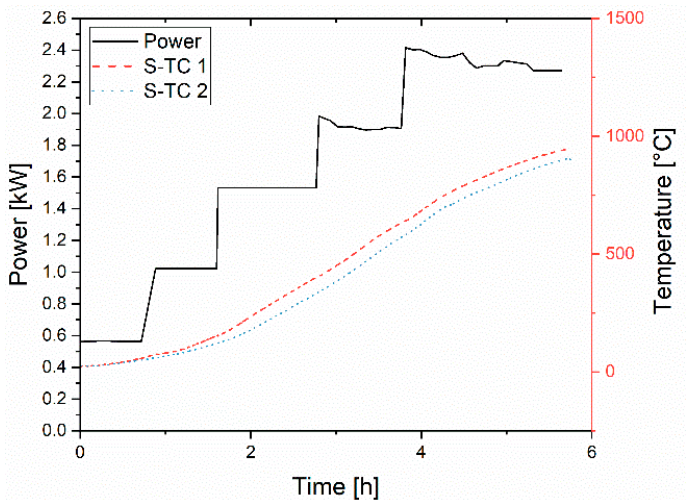
Figure 15. Experimental performance of LFP-C in Design 1, comparison of power and temperature over time.